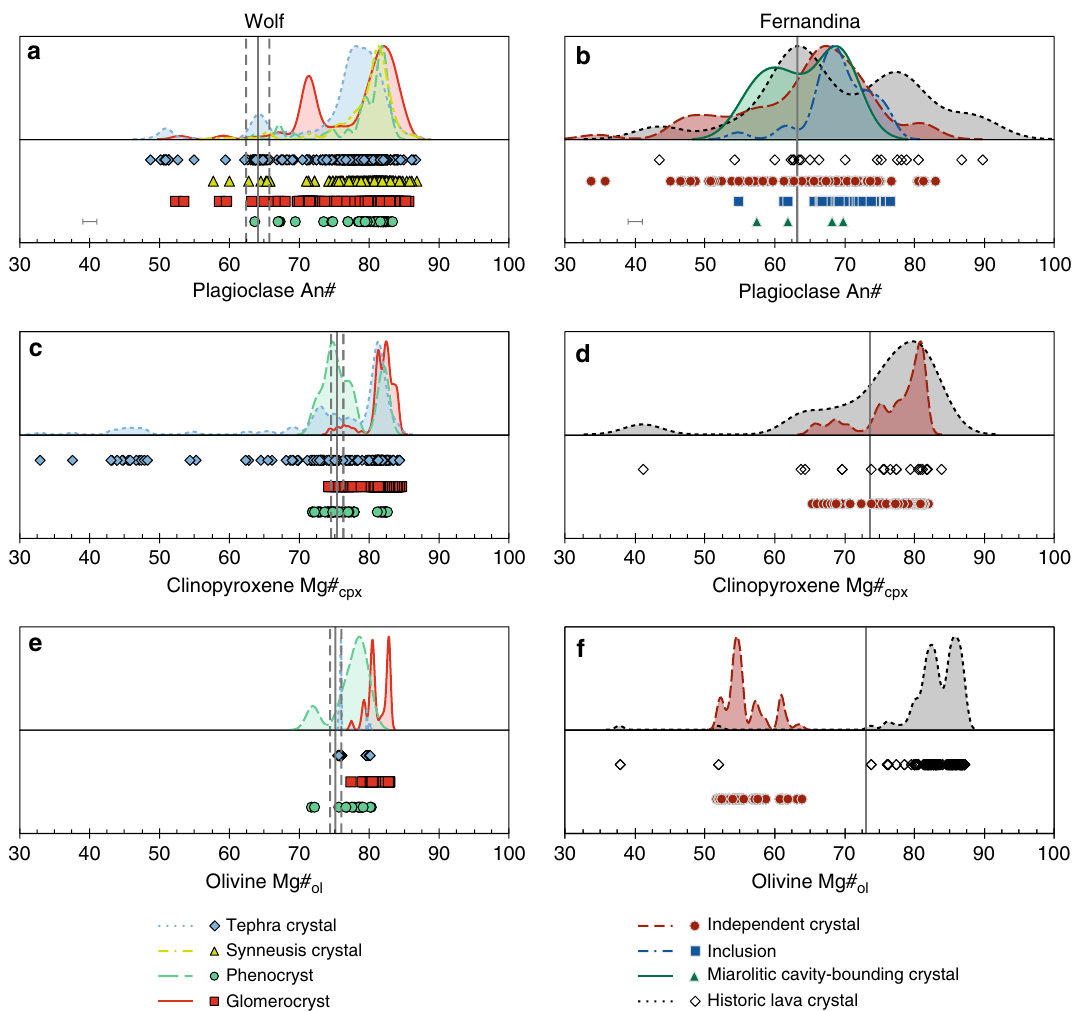
Fig. 4 Major element compositions of minerals from Wolf and Fernandina. a , b Plagioclase An#, c , d clinopyroxene Mg# cpx and e , f olivine Mg# ol in lava and tephra samples from the 2015 Wolf eruption, nodule samples from the 1968 Fernandina eruption and lava samples from historic Fernandina eruptions. Crystals are classi fi ed according to their textural association (see legend). Clinopyroxene compositions from the 2015 Wolf eruption are from Stock et al. 19 and crystal compositions from historic Fernandina lavas are from Allan and Simkin 28 and Koleszar et al. 35 . Characteristic 2 σ analytical uncertainties for our mineral analyses are either shown or are less than the size of a data point. The kernel density estimates above each panel show the distributions of the crystal compositions. The vertical grey lines show the compositions of crystals calculated to be in equilibrium with the 2015 Wolf tephra glass (solid lines — average composition; dashed lines — 1 σ compositional range) 19 and 1968 Fernandina scoria glass 28 . Equilibrium calculations were performed at 1160 °C for Wolf and 1130 °C for Fernandina (the approximate pre-eruptive crystallisation temperatures) 19, 28 , using the models of Namur et al. 67 for plagioclase, Putirka 68 for clinopyroxene and Herzberg and O ’ Hara 69 for